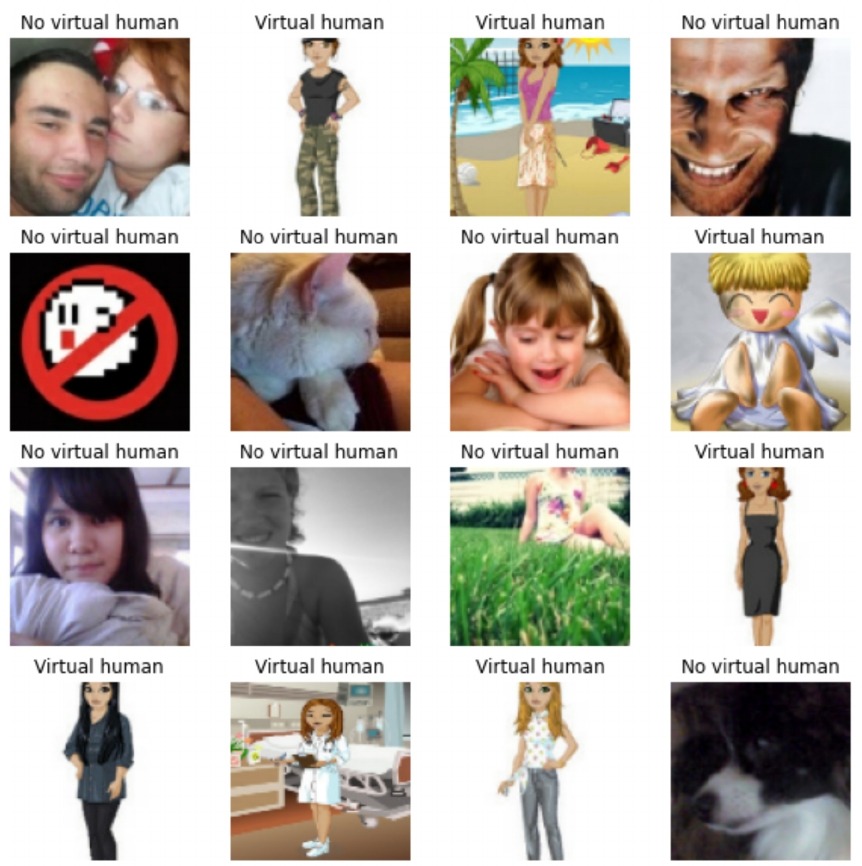
Figure 12. Samples of the virtual avatar dataset. The label Virtual human indicates a virtual human avatar; otherwise it does not correspond to a virtual human avatar.